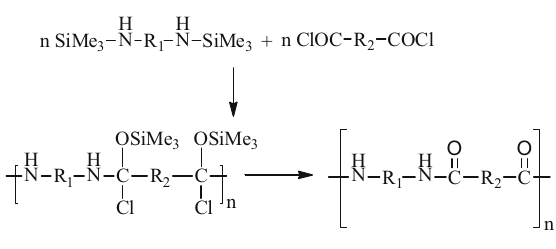
Scheme 6: Transition - metal catalyzed cabonylative coupling of diamines